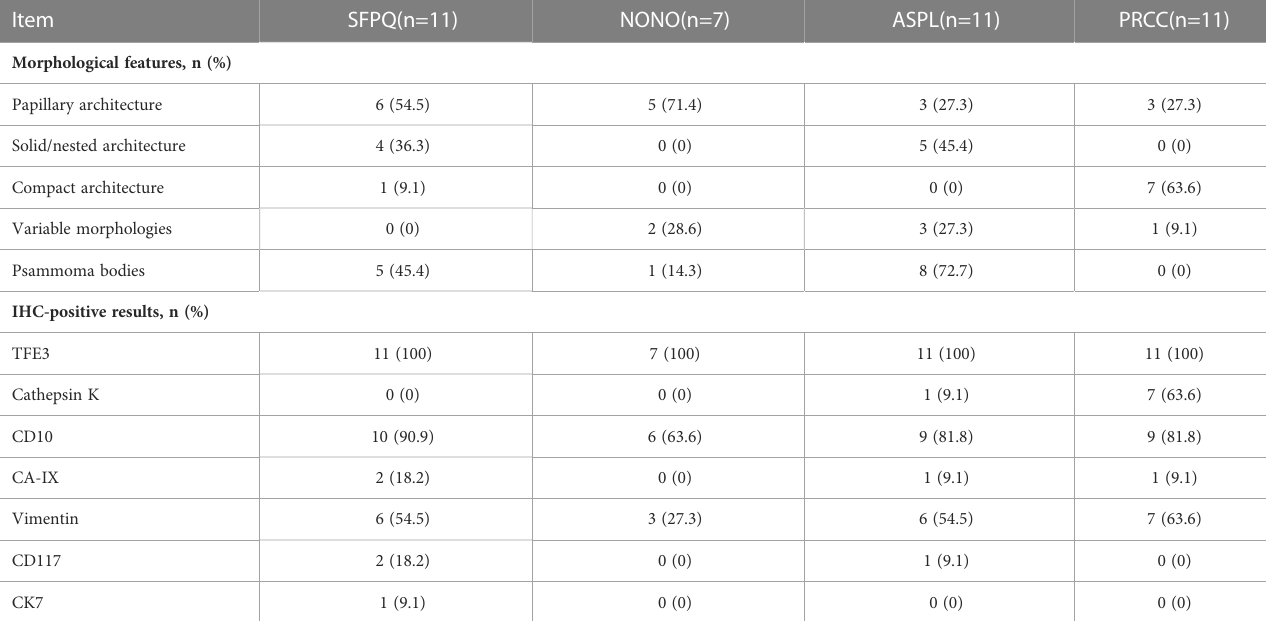
TABLE 2 Morphological and IHC features of the 40 Xp11.2 tRCC